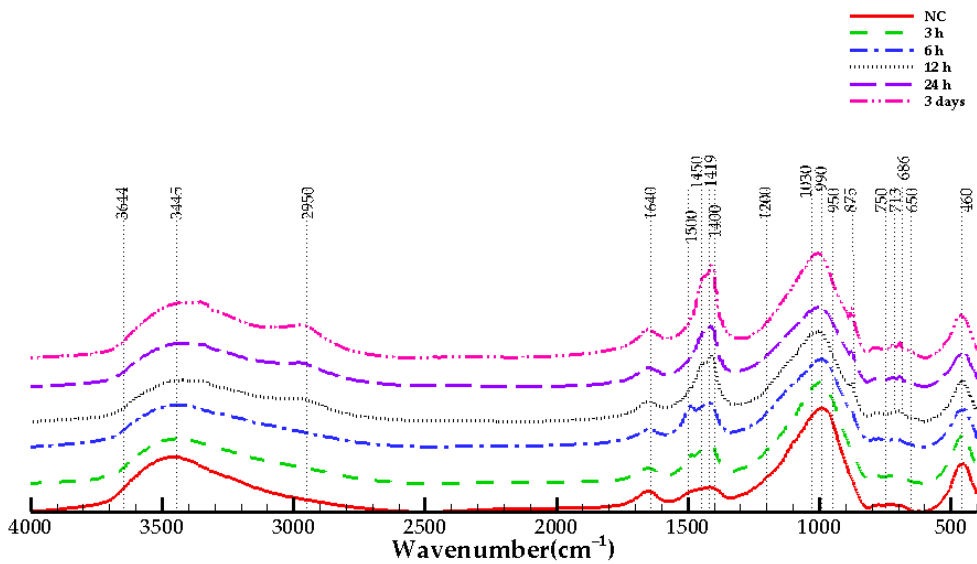
Figure 9. FTIR spectroscopy of NC and CO 2 cured samples .